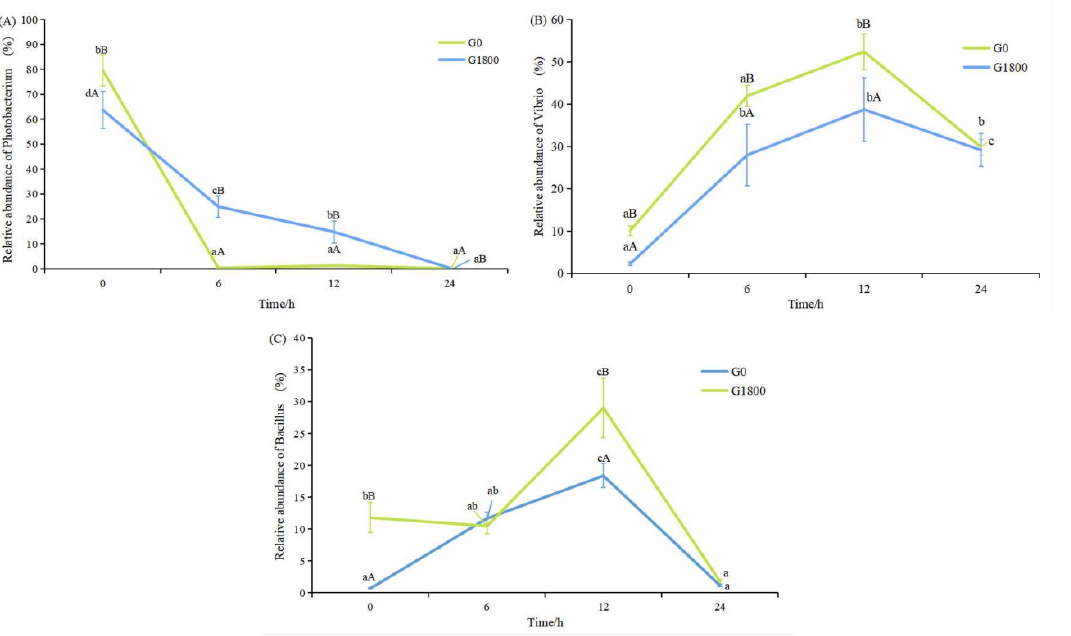
Figure 5. The effect of adding GML to diet on the indicator species of Photobacterium ( A ), Vibrio ( B ), and Bacillus ( C ) in grouper intestinal flora under salinity stress. Data represent means of three tanks in each group; error bar indicates S. D. Values with different letters are significantly different ( p < 0.05). “a, b, c” represents the significance between the same group at different times; “A, B” represents the significance between different groups at the same time